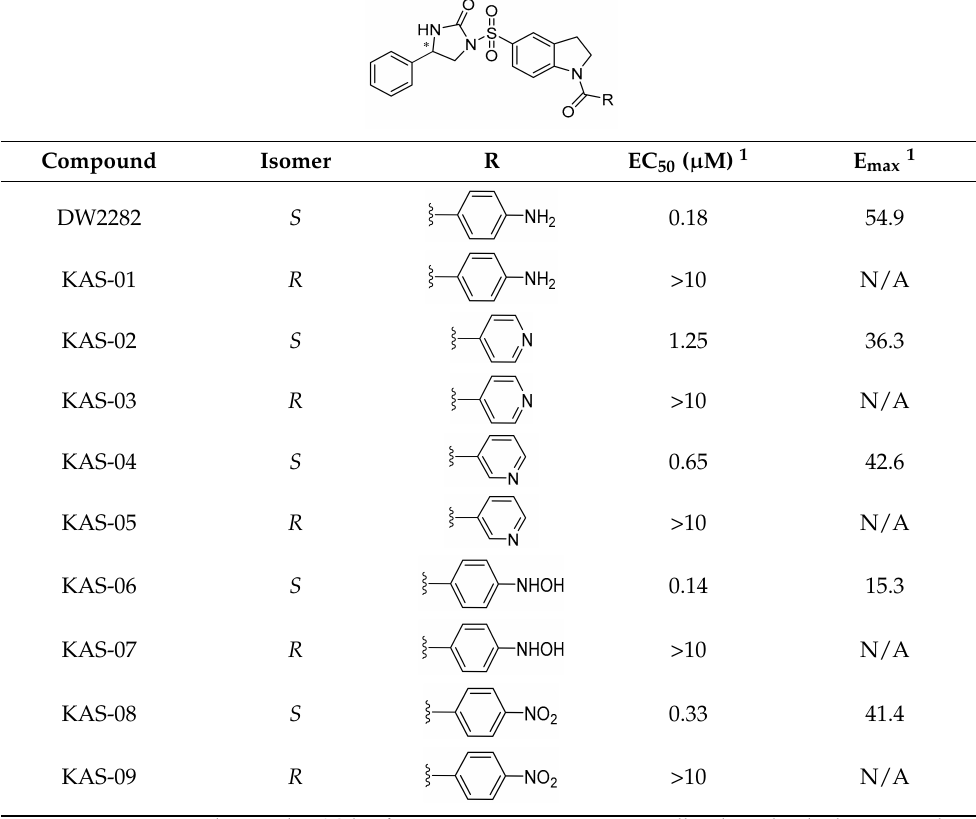
Table 1. Structure-activity relationship study for DW2282